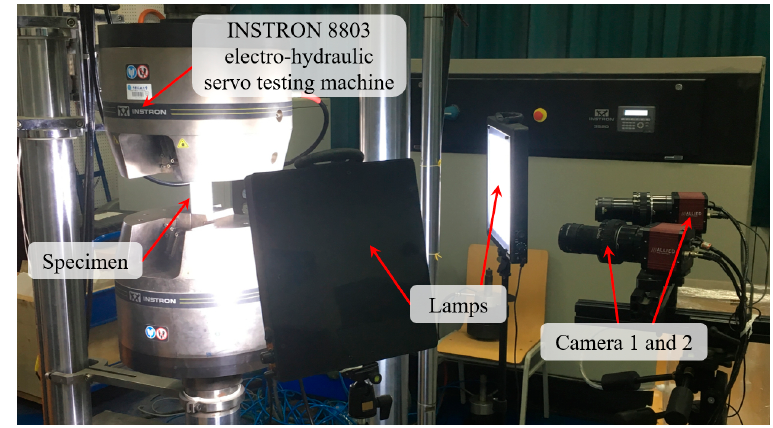
Figure 2. Experimental set-up.